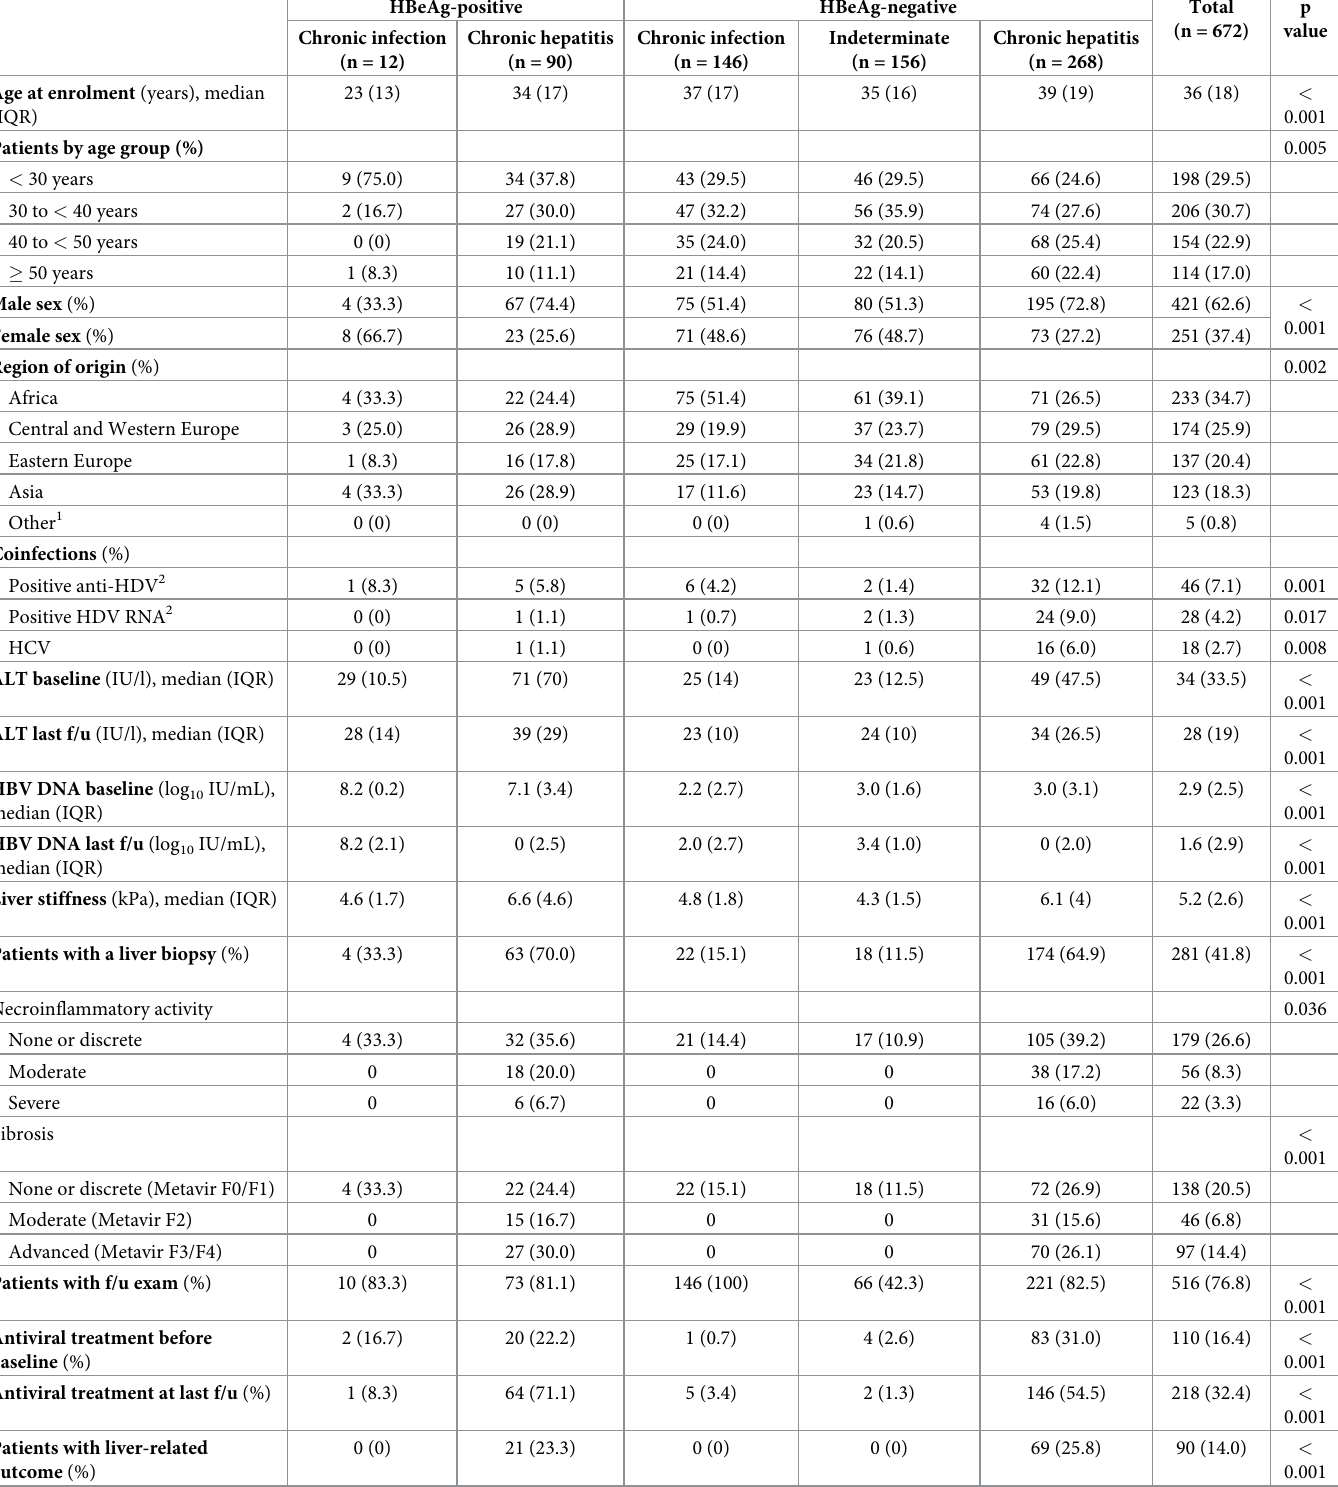
Table 1. Characteristics of patients included in the